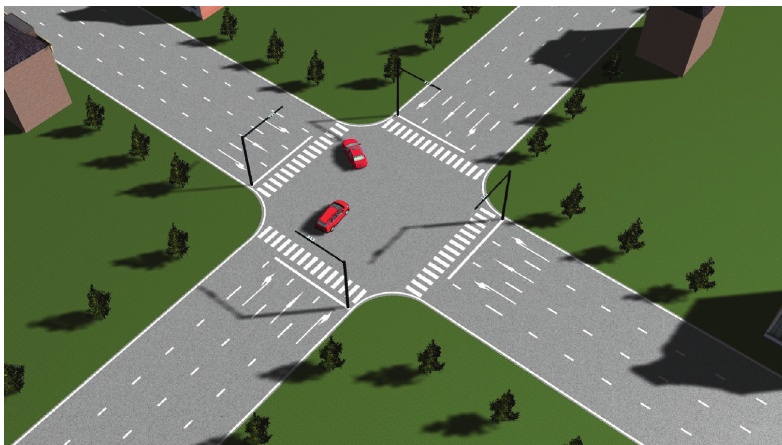
Figure 3: Simulation of the car-following process of turning vehicles at an